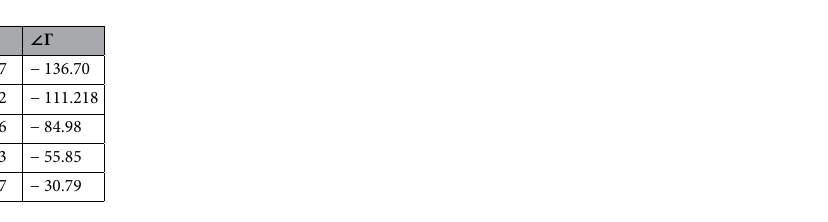
Table 1. Unit Cell Analysis at 5.36 GHz with fixed w = 2 mm and varying l.